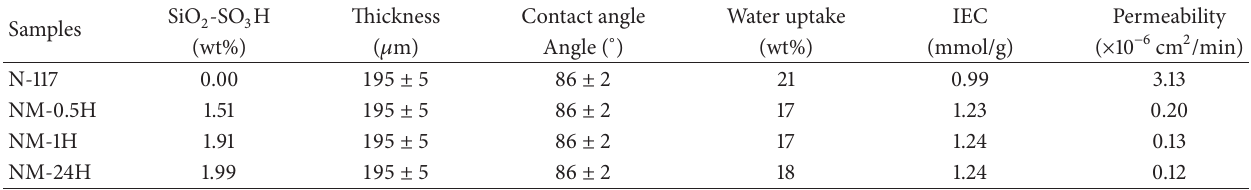
Table 1: Comparison of basic properties of N-117 and N-117/SiO 2 -SO 3 H membranes.